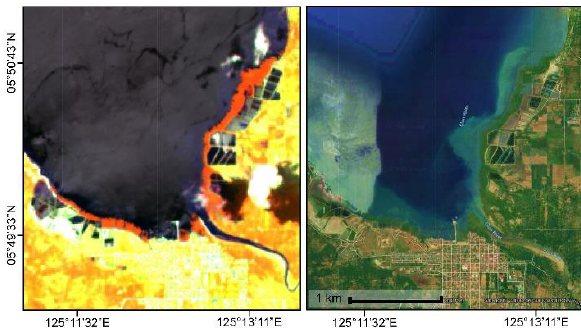
Figure 8 . Mangroves along Sarangani Bay in tile 51NYG that are unaccounted for in the 2019 Mangrove Extent Map of the